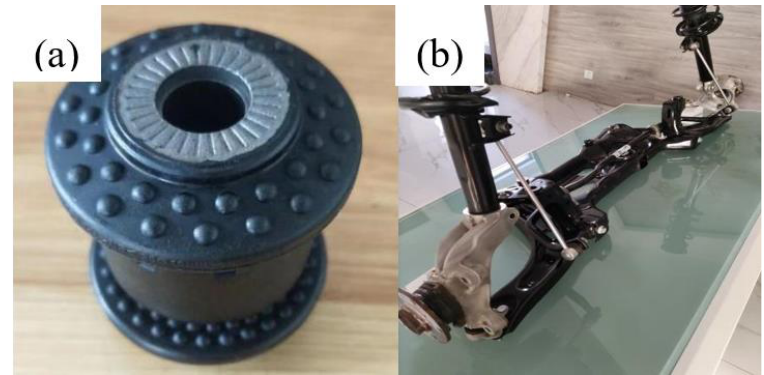
Figure 16. ( a ) Bionic rubber bushing. ( b ) Automobile front axle rocker arm.